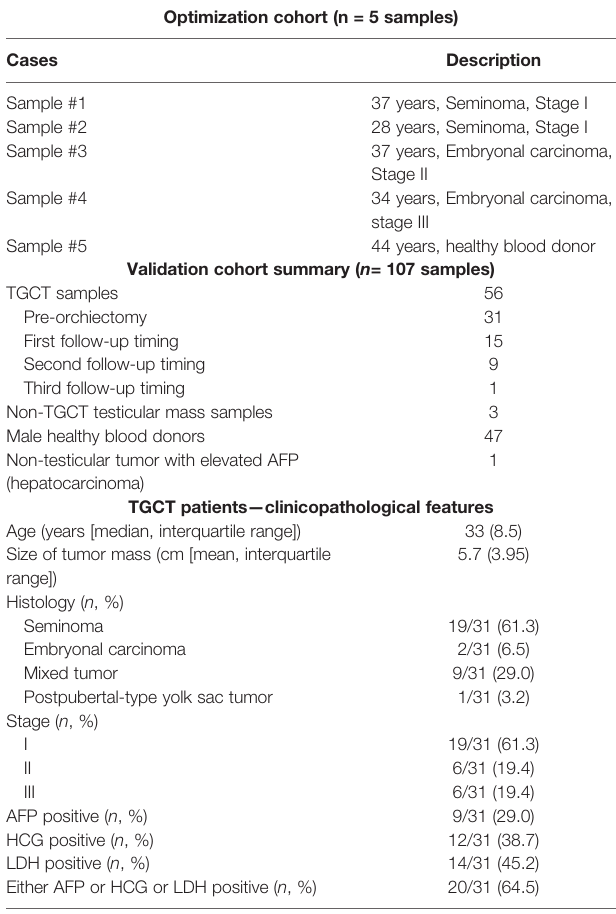
TABLE 1 | Clinicopathological description of the optimization and validation